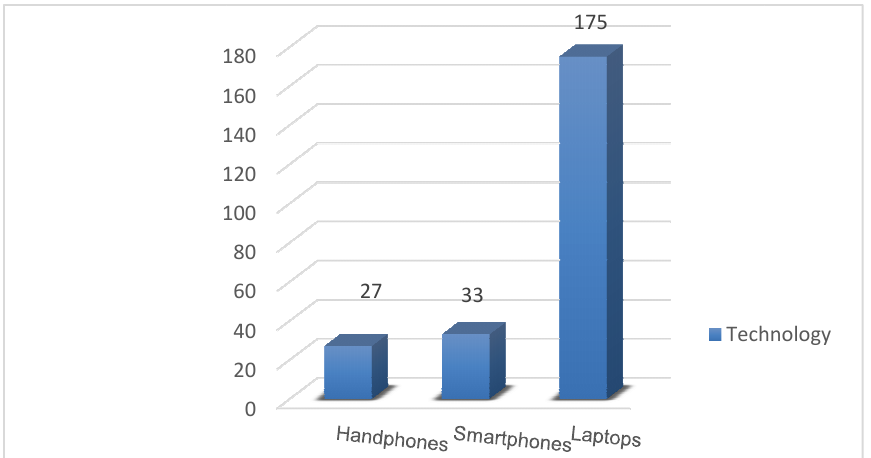
Figure 4. Willingness to Use Mobile Technology as Learning